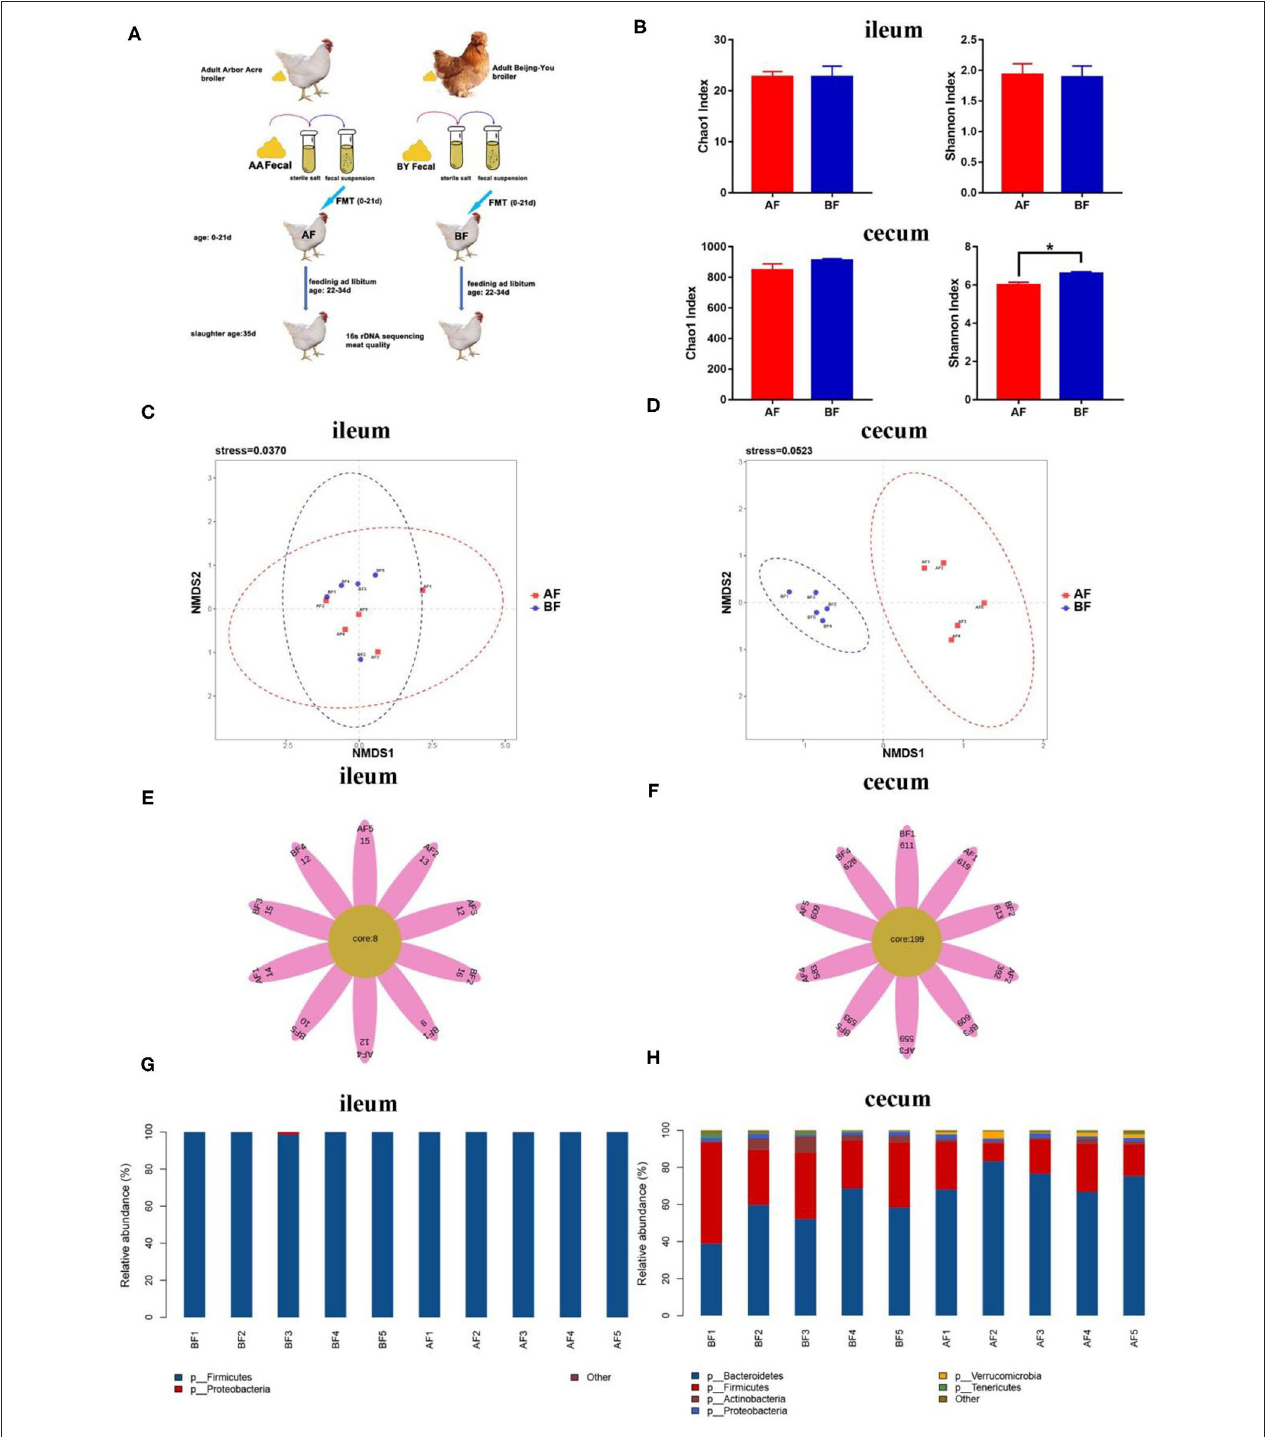
FIGURE 3 | 16s rDNA sequencing analysis of different breeds in ileum and cecum after fecal microbiota transplantation (FMT). (A) Graph of FMT experiment. (B) Alpha diversity analysis of the Chao1 index and the Shannon index. (C,D) Scatterplot from NMDS in bacterial composition. (E,F) Venn flower diagram of core OTUs in ileum and cecum. (G,H) Intestinal microbiota structure of ileum and cecum at the phylum level. AF: Fecal transfer from the Arbor Acres broilers into the Arbor Acres broiler; BF: fecal transfer from the Beijing-You broilers into the Arbor Acres broilers. The numbers of independent biological samples analyzed in panel B to H were AF ( n = 5) and BF ( n = 5). Data in (B) are expressed as mean ± SEM. Data in (B) were analyzed using ANOVA, followed by the Tukey’s test, and were considered as statistically significant at * p < 0.05 between the indicated groups. Data in (C,D) were analyzed using nonmetric multidimensional scaling. Data in (C–H) statistical tests were two-sided and the differences were considered to be statistically significant at p <